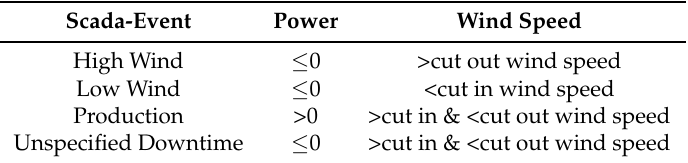
Table 4. Description of scada-events for a timestamp with power and wind speed